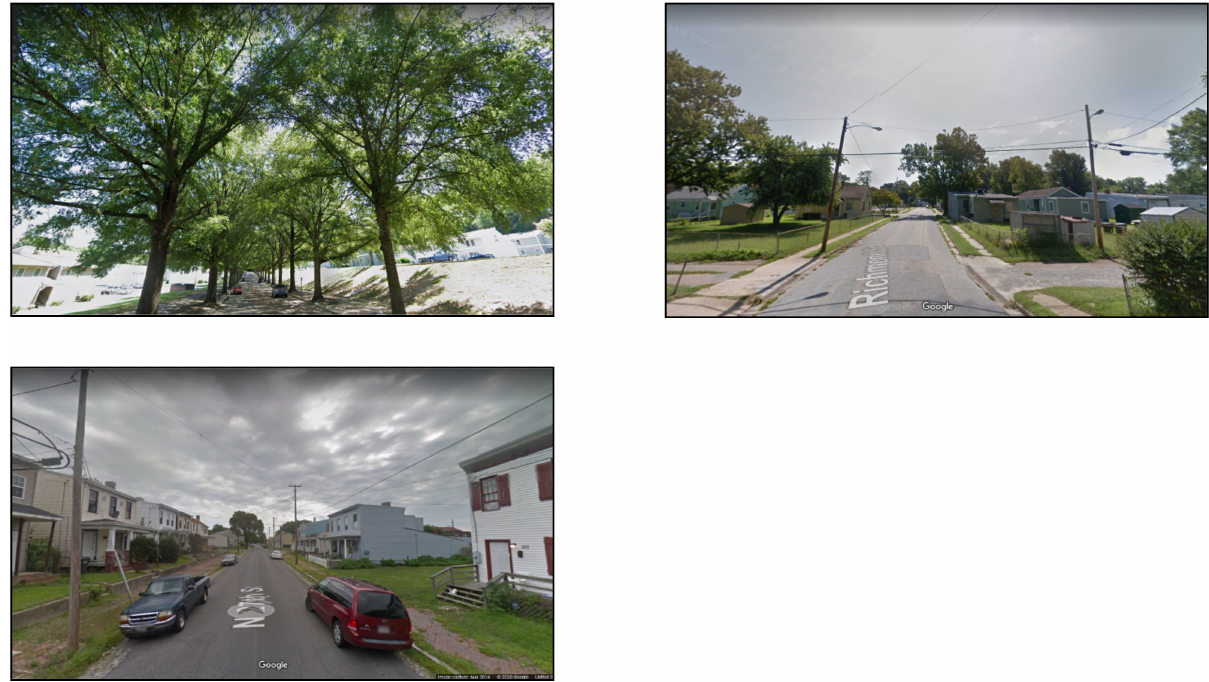
Figure 1. Examples of Google Street View images captured from residential locations in the study area where the GVI is more than one standard deviation above the mean ( top left ), at about the mean ( top right ), and more than one standard deviation below the mean ( bottom left ).